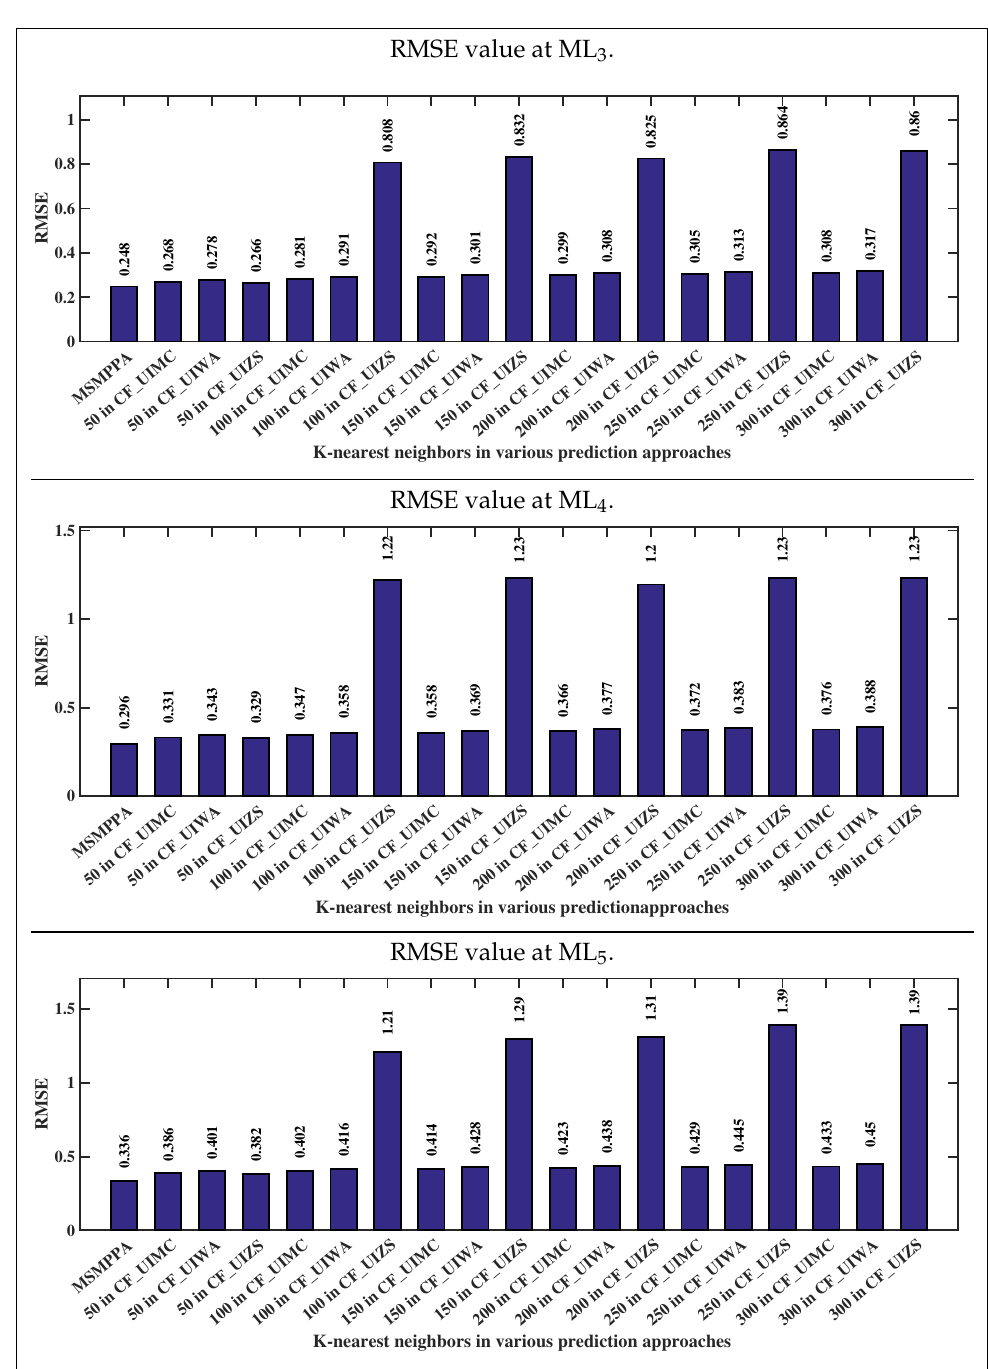
Figure 13. RMSE Value at